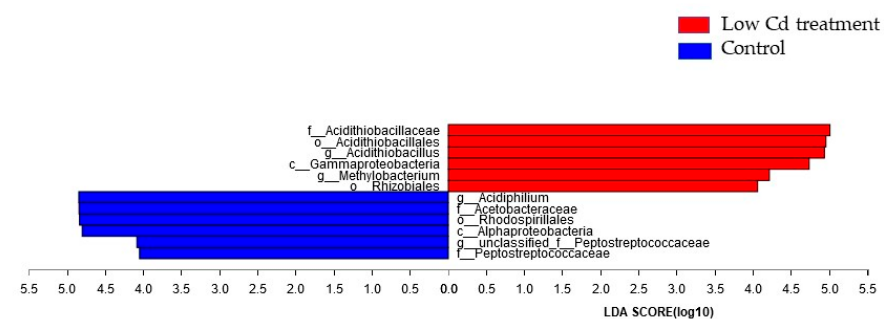
Figure 4. The most differentially abundant taxa between the control and low Cd treatment groups which was identified through the LDA score generated from linear discriminant analysis effect size (LEfSe) analysis.